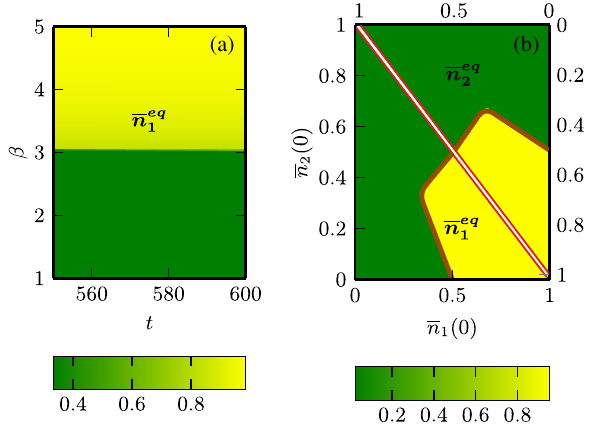
FIG. 3. Density plot of the equilibrium occupation density ¯ n eq 1 for different β and times t for an initial condition ¯ n ð 0 Þ equal to the symmetric FP in (a) and as a function of all physical initial conditions ¯ n 1 ð 0 Þ and ¯ n 2 ð 0 Þ at time t ¼ 10 3 and for β ¼ 4 . 0 in (b) (lower-left triangle). For completeness, the upper-right tri- angle in (b) shows the other component ¯ n eq 2 . The times are chosen to be sufficiently long such that the system has relaxed to